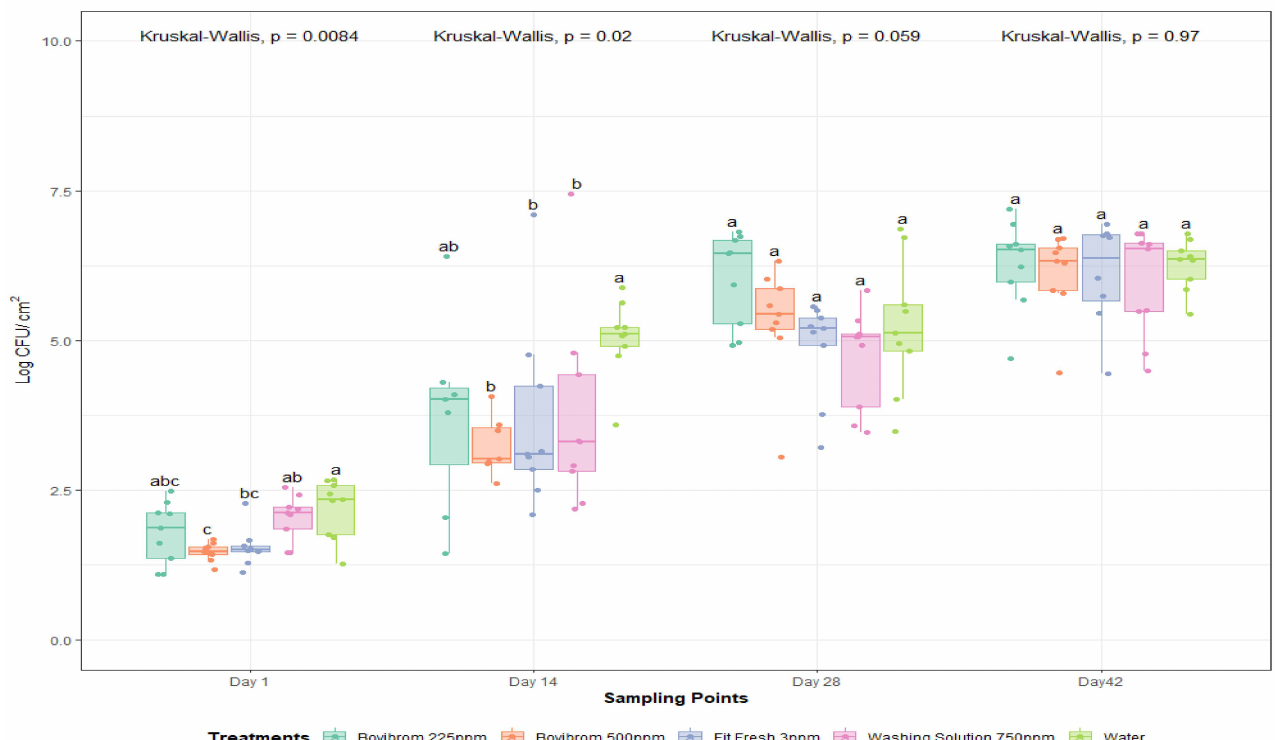
Figure 4. Psychrotrophic aerobic plate counts (Log CFU/cm 2 ) after 1, 14, 28, and 42 days of dark storage time on pork loin sections ( n = 45 per dark storage time). In each boxplot, the horizontal line crossing the box represents the median, the bottom and top of the box are the lower and upper quartiles, the vertical top line represents the upper interquartile range, and the vertical bottom line represents the lower interquartile range. For each sampling point day, boxes with different letters a,b are significantly different according to Kruskal–Wallis analysis followed by pairwise comparison Wilcoxon’s test at p < 0.05. The points represent the actual data points. Active ingredients: Bovibrom = 1,3-Dibromo-5,5-dimenthylhydantoin; Fit Fresh = chlorine dioxide; Washing Solution =